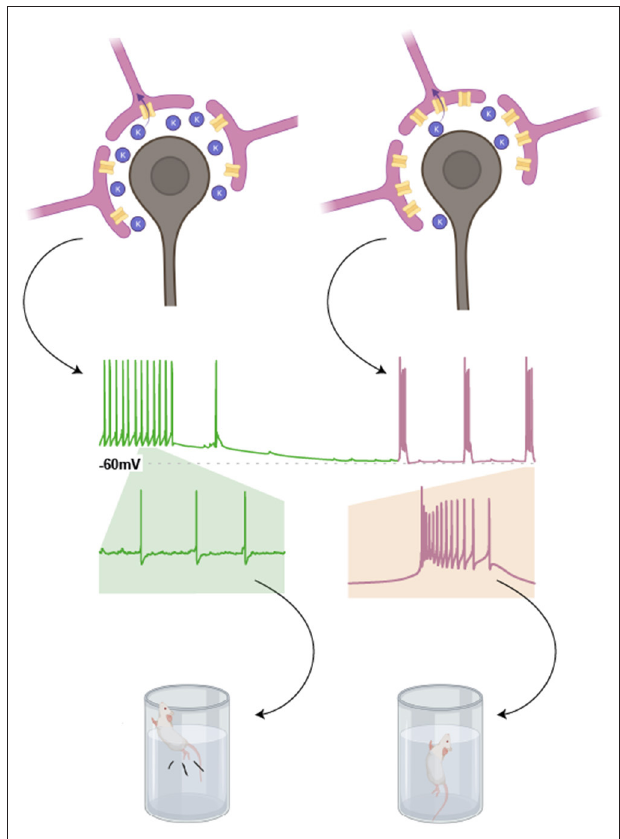
FIGURE 4 | Astrocytic expression of Kir4.1 promotes burst firing in neighbouring LHb neurones. Expression of the inwardly rectifying potassium channel, Kir4.1, in astrocytic processes surrounding the somata of LHb neurones, lowers the concentration of K + in the extracellular space. This is because K + is taken up by these astrocytes. According to the Nernst equation, this results in a more negative resting membrane potential for neighbouring LHb neurones (as indicated in the cartoon trace). This in turn promotes burst firing in LHb neurones, a phenomenon associated with depressive phenotypes in rodent models (Drawn with